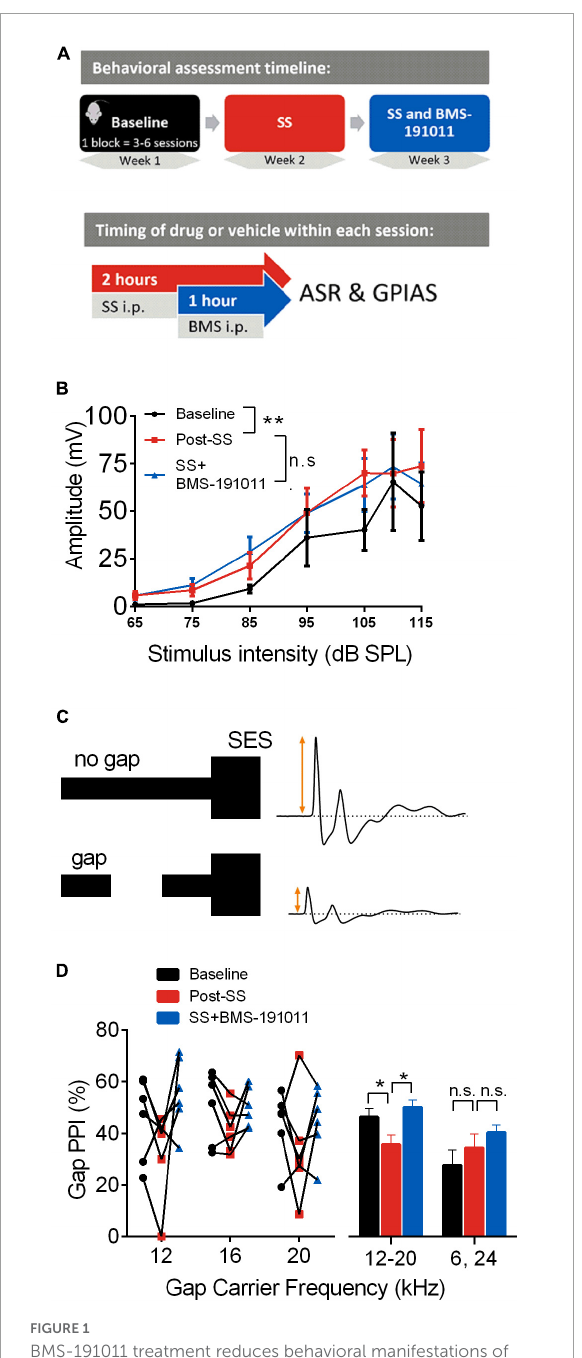
FIGURE1 BMS-191011 treatment reduces behavioral manifestations of drug-induced tinnitus. (A) Schematic showing the timing of behavioral assessment used to assess the effects of BMS-191011. The behavior of each mouse ( N = 6) was assessed in sequential blocks of treatment (upper panel). Each treatment block was 3–6 sessions that extended over 1–2 weeks. Within a session (lower panel), SS or vehicle was administered i.p. 2 h prior to assessment, and BMS-191011 or vehicle was administered i.p. 1 h prior to assessment. (B) Startle amplitude plotted as a function of SES intensity from 65 to 115 dB SPL. A two-way RM ANOVA indicated a main effect of intensity ( F (1.217,6.084) = 13.34; p < 0.01). Though there was not a main effect of treatment